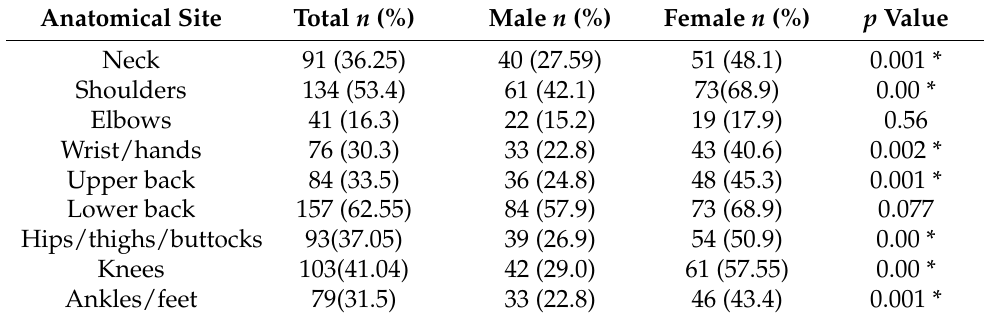
Table 3. Anatomical distribution of musculoskeletal symptoms and association of anatomical sites with gender.